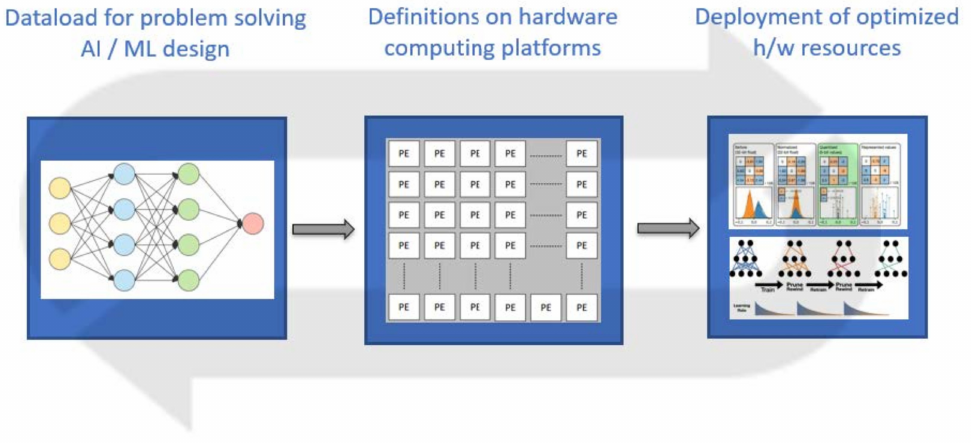
Figure 1. The end-to-end AI/ML design